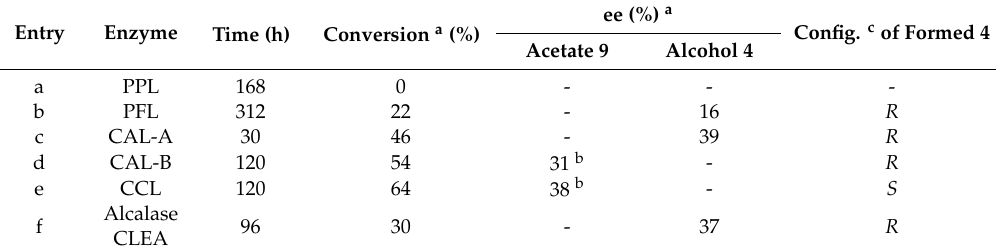
Table 1. Enzyme-catalyzed hydrolysis of acetate rac - 9 .